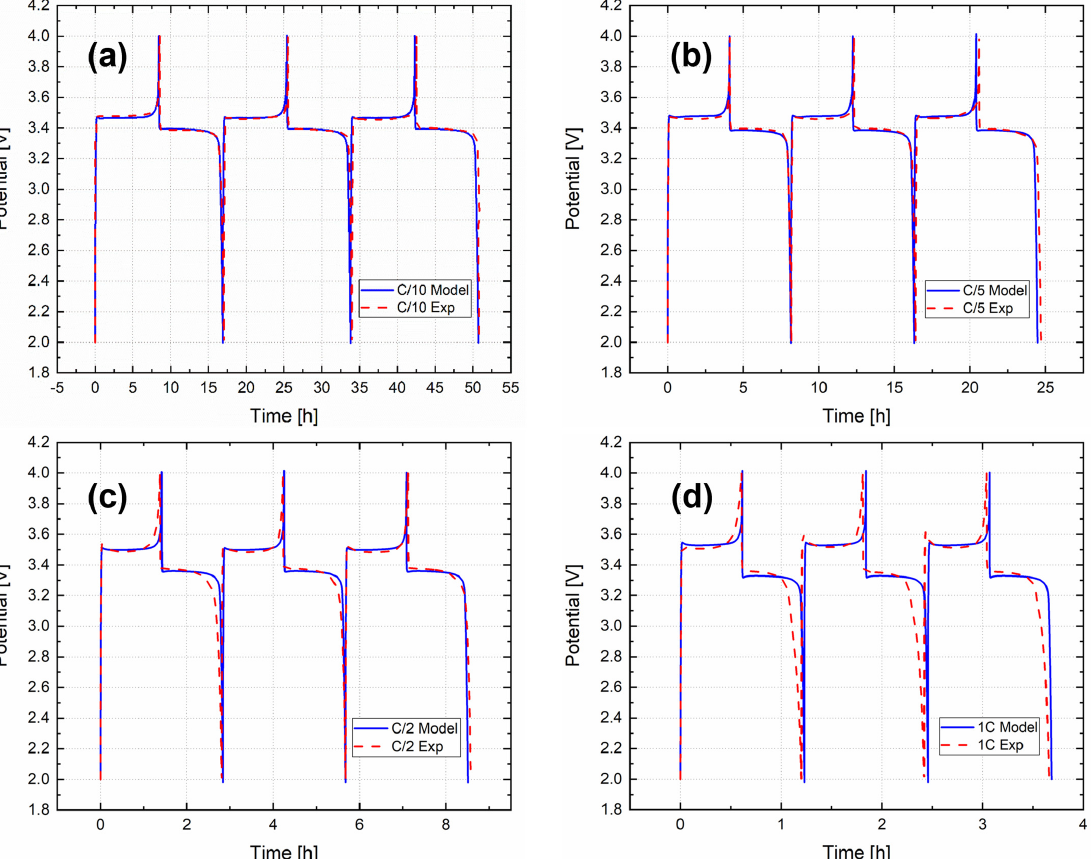
Figure 4. Validation of the P2D electrochemical model for the 4 different C rates, ( a ) C/10, ( b ) C/5, ( c ) C/2 and ( d ) 1C. ( c ) C/2 and ( d )